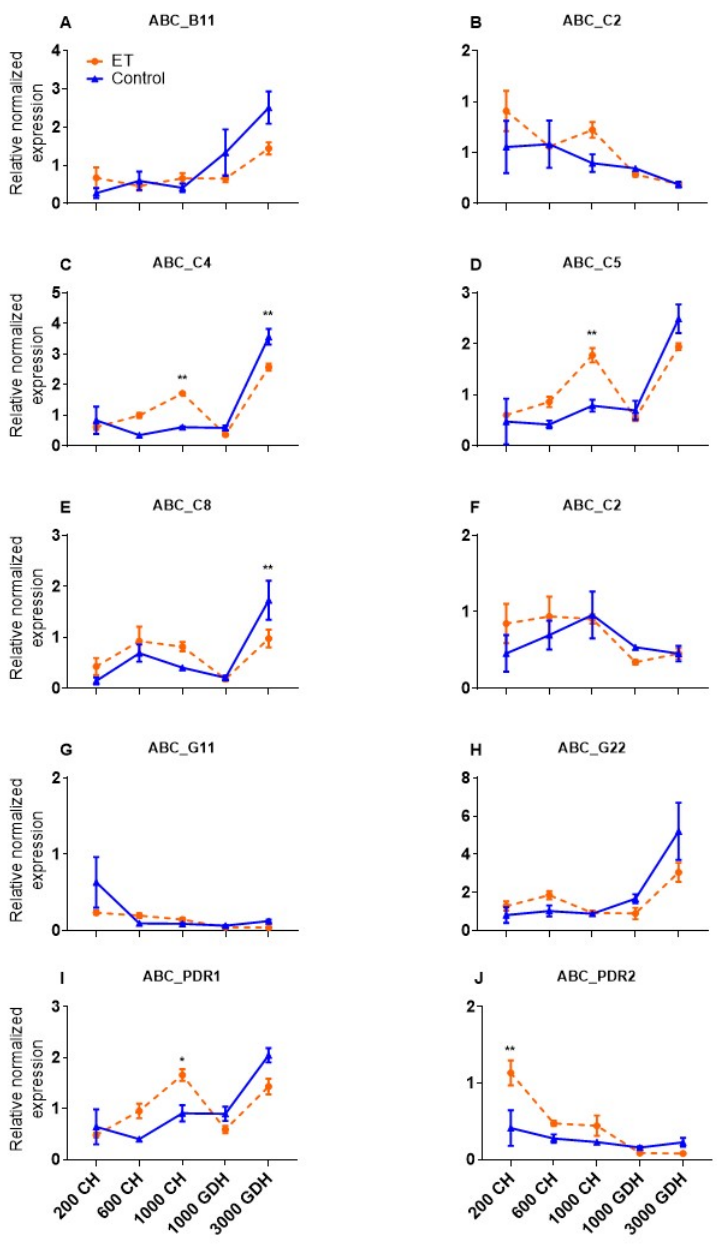
Figure 5. RT-qPCR validation of the expression of 10 ABC transporter genes ( A – J ), which were downregulated at 600 CH and upregulated at 1000. Each datapoint represents the mean ± SE of three biological replicates, each with two technical replicates. Significant differences are marked by asterisks (* p < 0.05, ** p < 0.01).